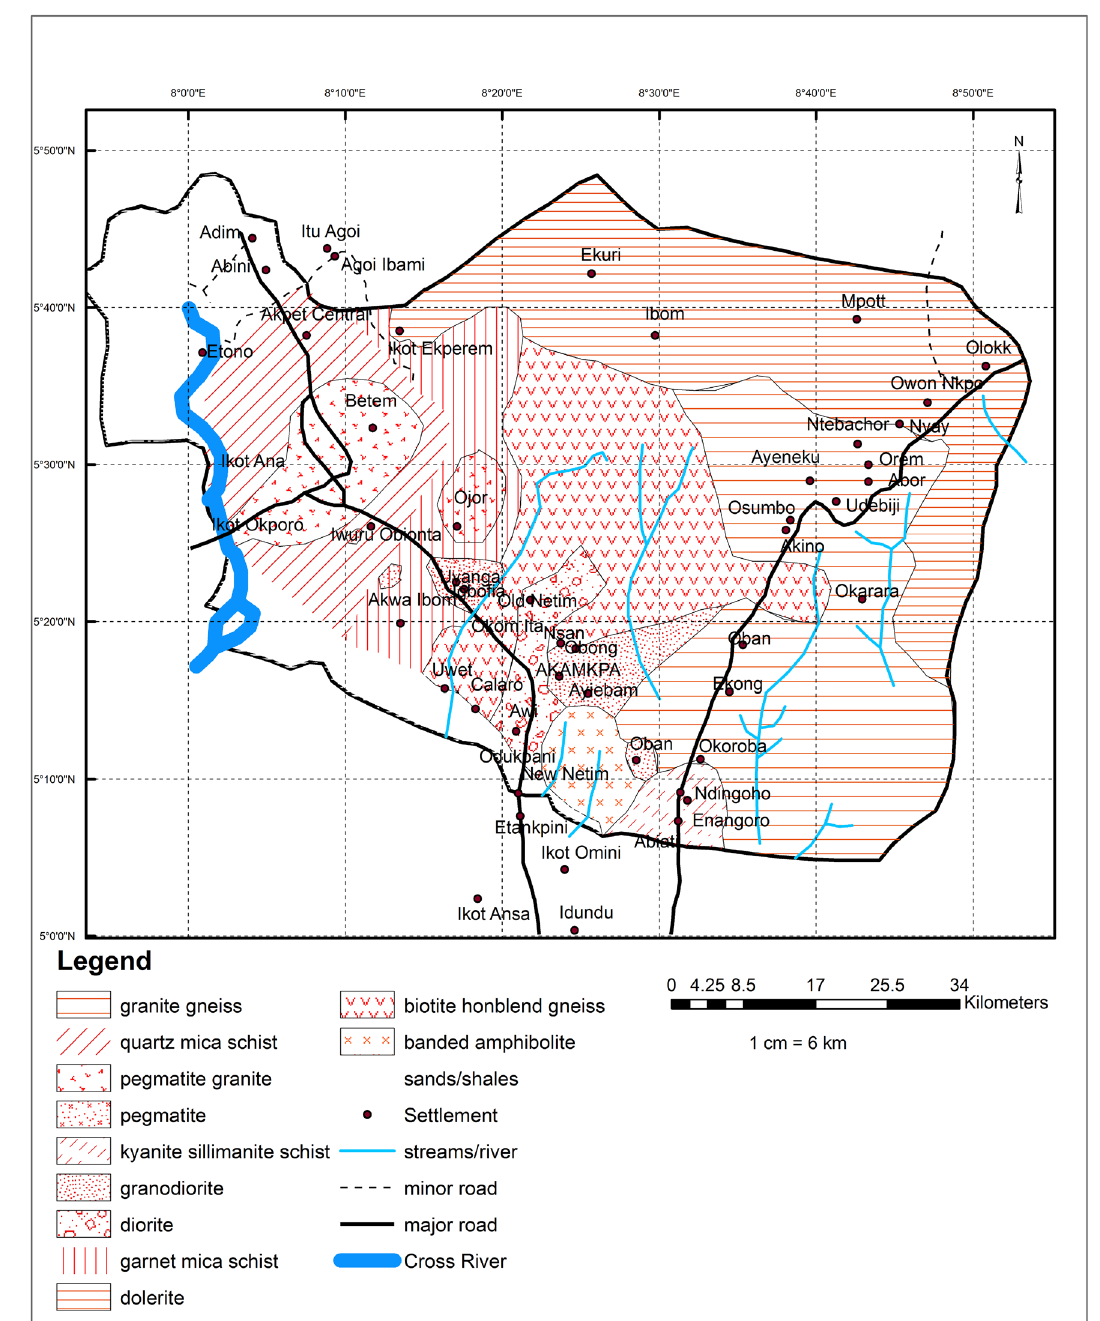
Fig. 3 Modeled geological map of the study